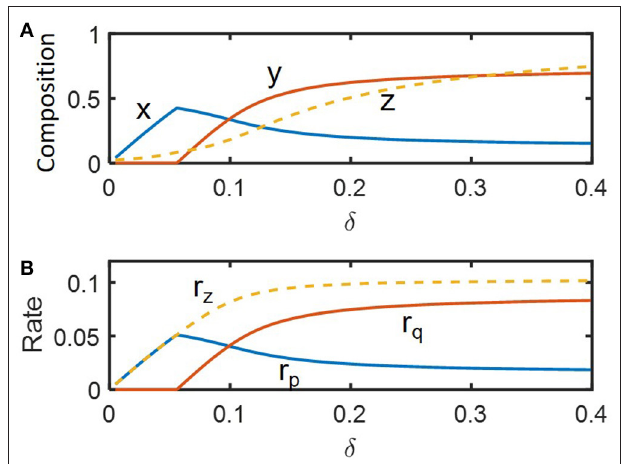
FIGURE 2 | The changes in key variables and functions in steady state as a function of flow rate ( δ ): (A) species abundances ( x and y ) and substrate concentration ( z ), and (B) consumption rate of the shared substrate ( r z ) and production rates of distinct products ( r p and r q ).